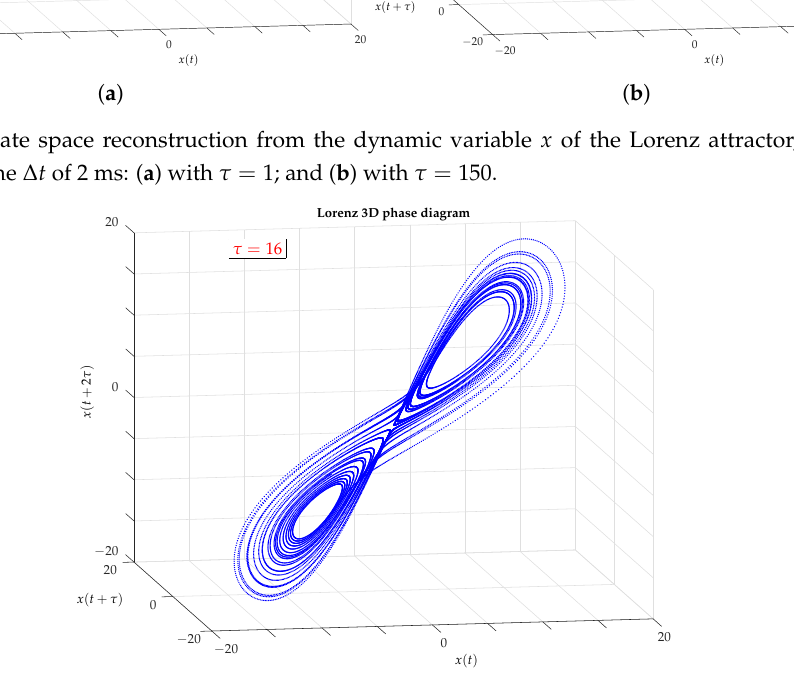
Figure 6. State space reconstruction from the dynamic variable x of the Lorenz attractor, with a sampling time ∆ t of 2 ms and τ =